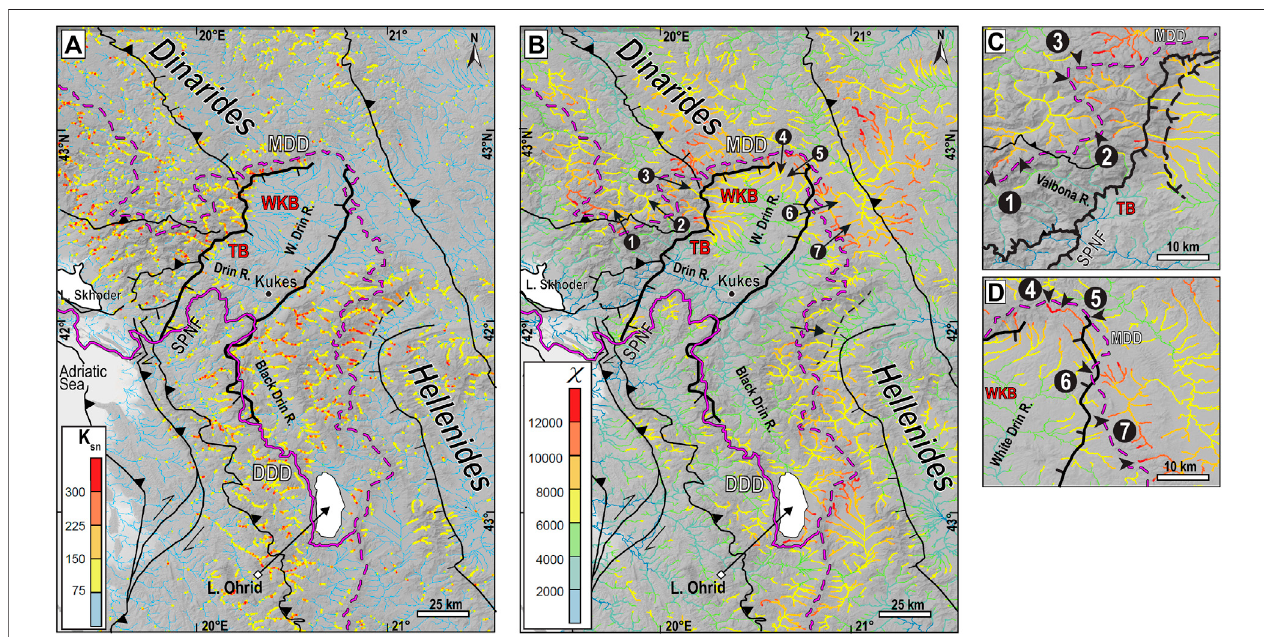
FIGURE 9 | Stream metrics for the Dinaric-Hellenic junction, including the MDD – main drainage divide (purple dashed line), the DDD – Drin drainage divide (thin purple line) and main faults (thin black lines), including the SPNF (thick black line): (A) Map of river steepness index, k sn ; (B) χ -map showing the degree of adjustment to current steady-state conditions using the Adriatic Sea as abase level. Note the contrast in k sn and χ values acrossthe MDD, which partly coincides with theDDD, and in the footwall of the main normal fault of the SPNF; (C – D) Close-ups of the drainage divide in the footwall of the SPNF system showing the in fl uence of the fault on patterns of χ values. Arrows indicate the predicted motion of the drainage divide. TB = Tropoja Basin; WKB = Western Kosovo Basin. Shaded relief based on SRTM-1 arc-second DEM (USGS, 2014).